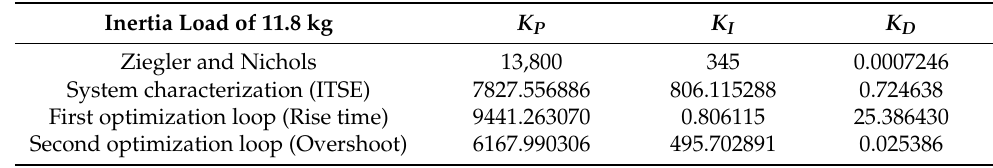
Table 3. PID parameters for Ziegler and Nichols, the system characterization, and the two optimi- zation loops for the inertia of 11.8 kg.